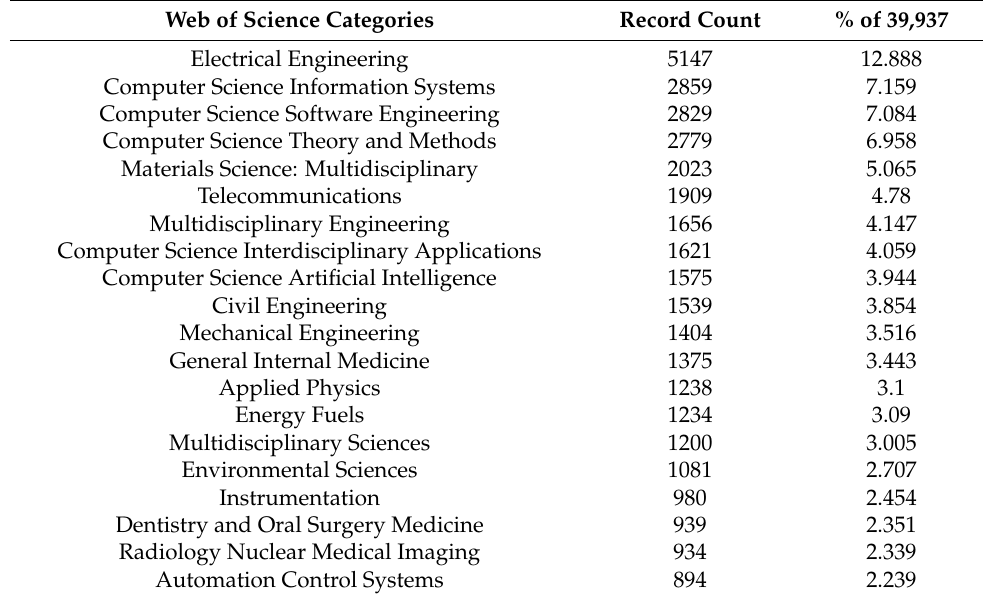
Table 6. Top 20 WoS Categories based on record count of publications